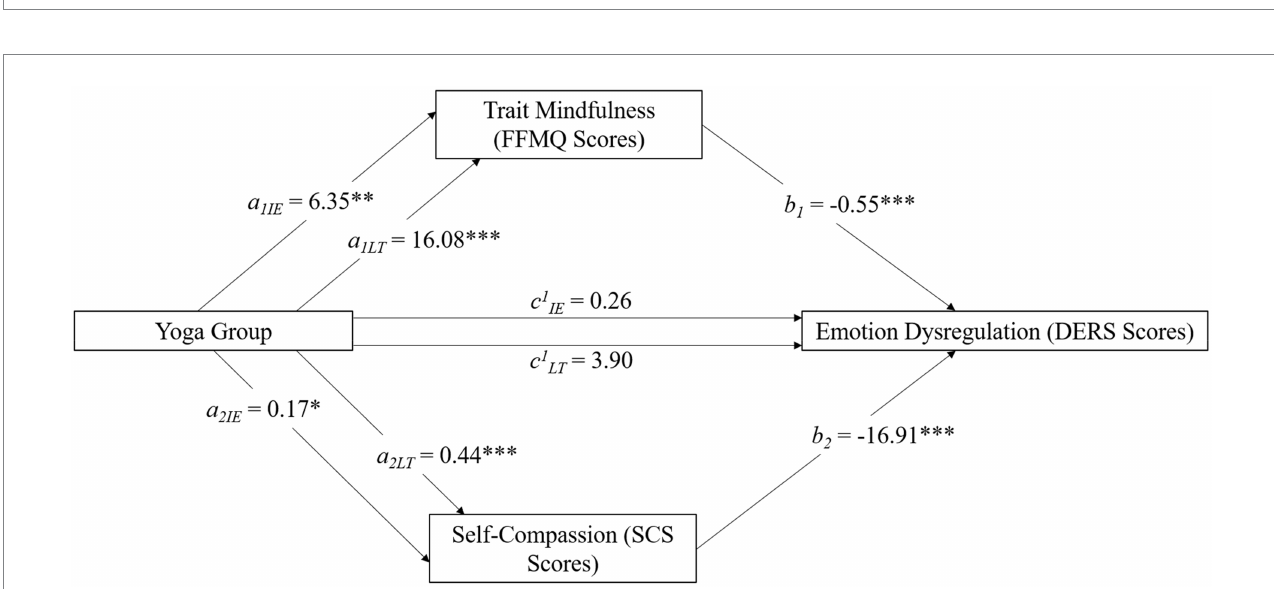
FIGURE 3 Mediation model featuring yoga practice (predictor), emotion dysregulation (outcome), and two mediators (self-compassion and trait mindfulness). Variables with subscript IE represent a comparison between the no experience and intermittent experience (IE) group. Subscript LT represents a comparison between the no experience and the long-term (LT) group. This model demonstrates that the relationship between intermittent and long-term yoga practice and emotion dysregulation is mediated by trait mindfulness and self-compassion. Significance is represented as * ( p < 0.05), ** ( p < 0.01), or *** ( p < 0.001). No asterisk represents a non-significant